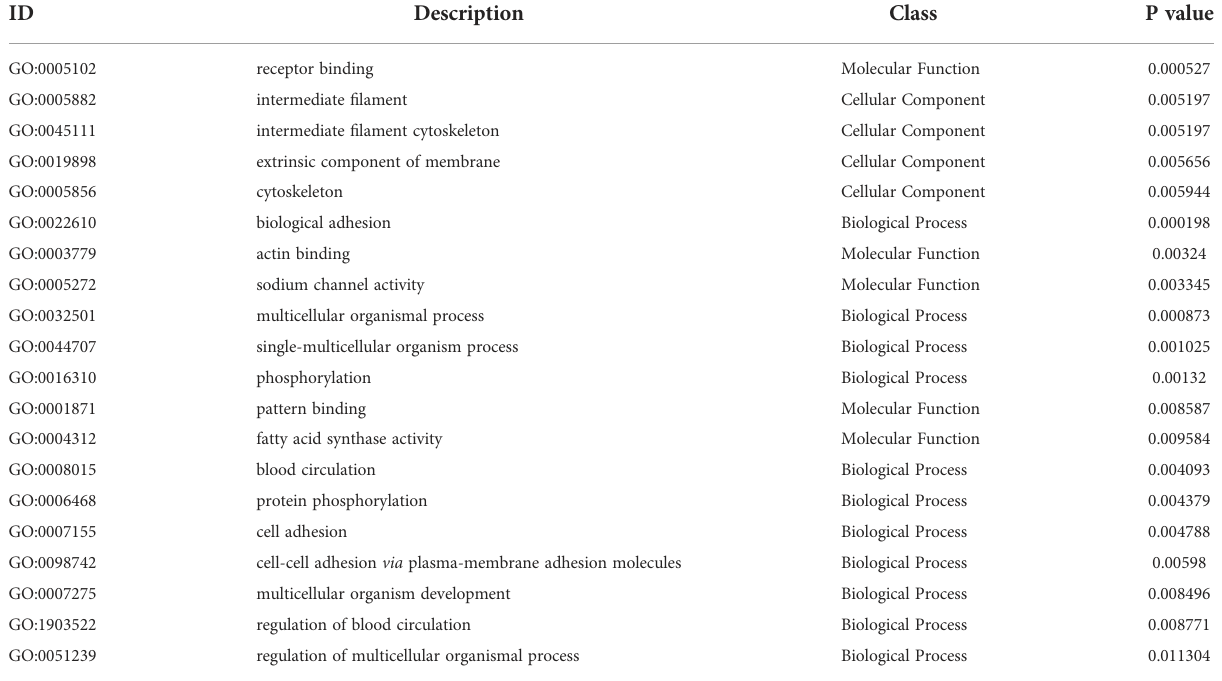
TABLE 4 ID, description, class and speci fi c P-value of Top 20 GO terms at 7 th post immunization day.